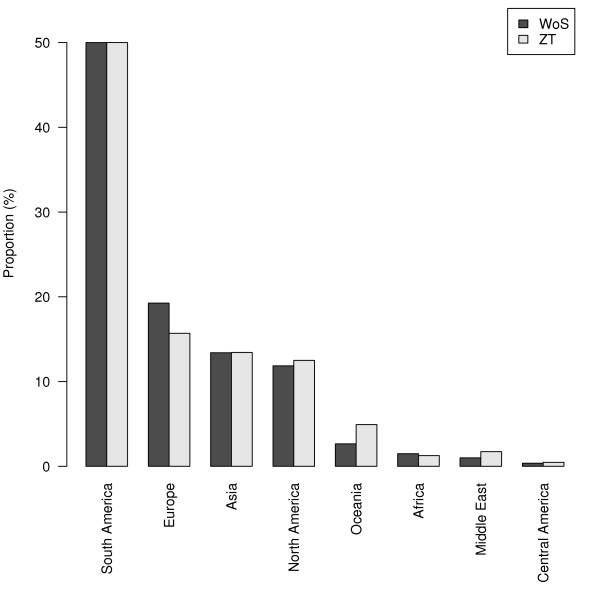
Comparison of the proportion of regions publishing new species in 2006 in journals indexed in the Web of Science (WoS, 4313 articles) and in the Zootaxa subset (ZT, 675 articles). Search query: ("sp nov" OR "new species") AND "2006".